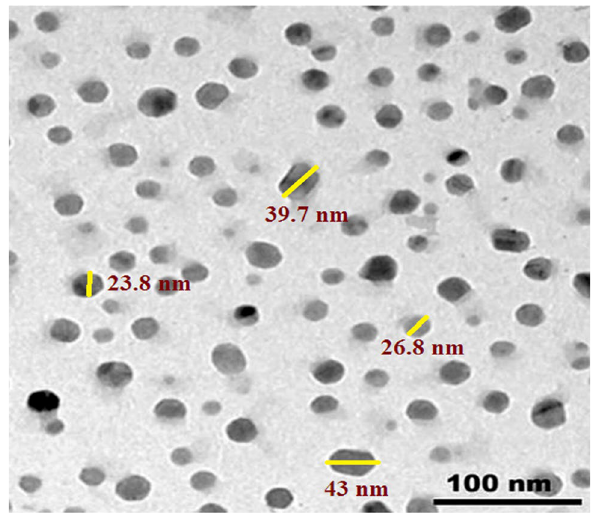
Figure 1. TEM image of nano-lead oxide particles.